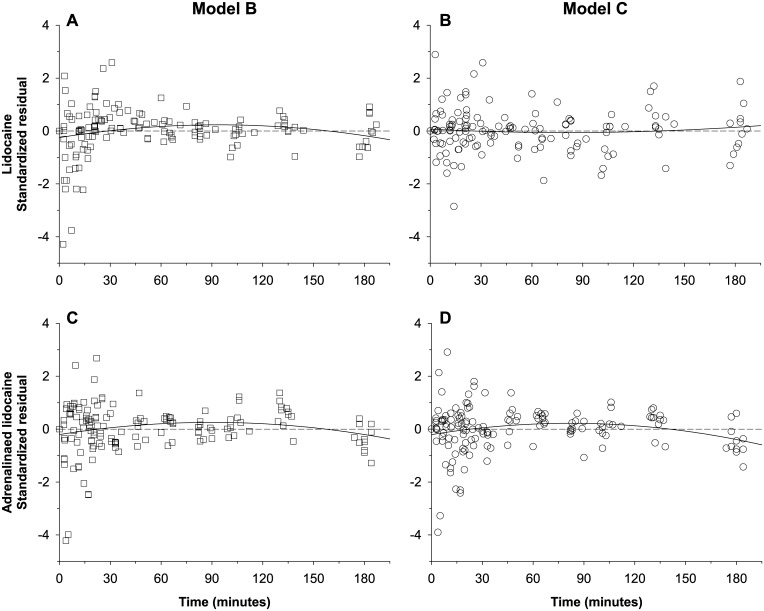
Lidocaine standardized residuals of the alternative and refined alternative compartmental models vs. time following lidocaine administration.(A) Plain lidocaine data predicted by Model B (i.e. with two asynchronous first-order absorption rates per system). (B) Plain lidocaine data predicted by Model C (i.e. with two time-constrained, asynchronous zero-order absorption rates per system). (C) Adrenalinated lidocaine data predicted by Model B. (D) Adrenalinated lidocaine data predicted by Model C. A third-degree polynomial curve (continuous line) has been added to help visualizing the trend in the residuals.